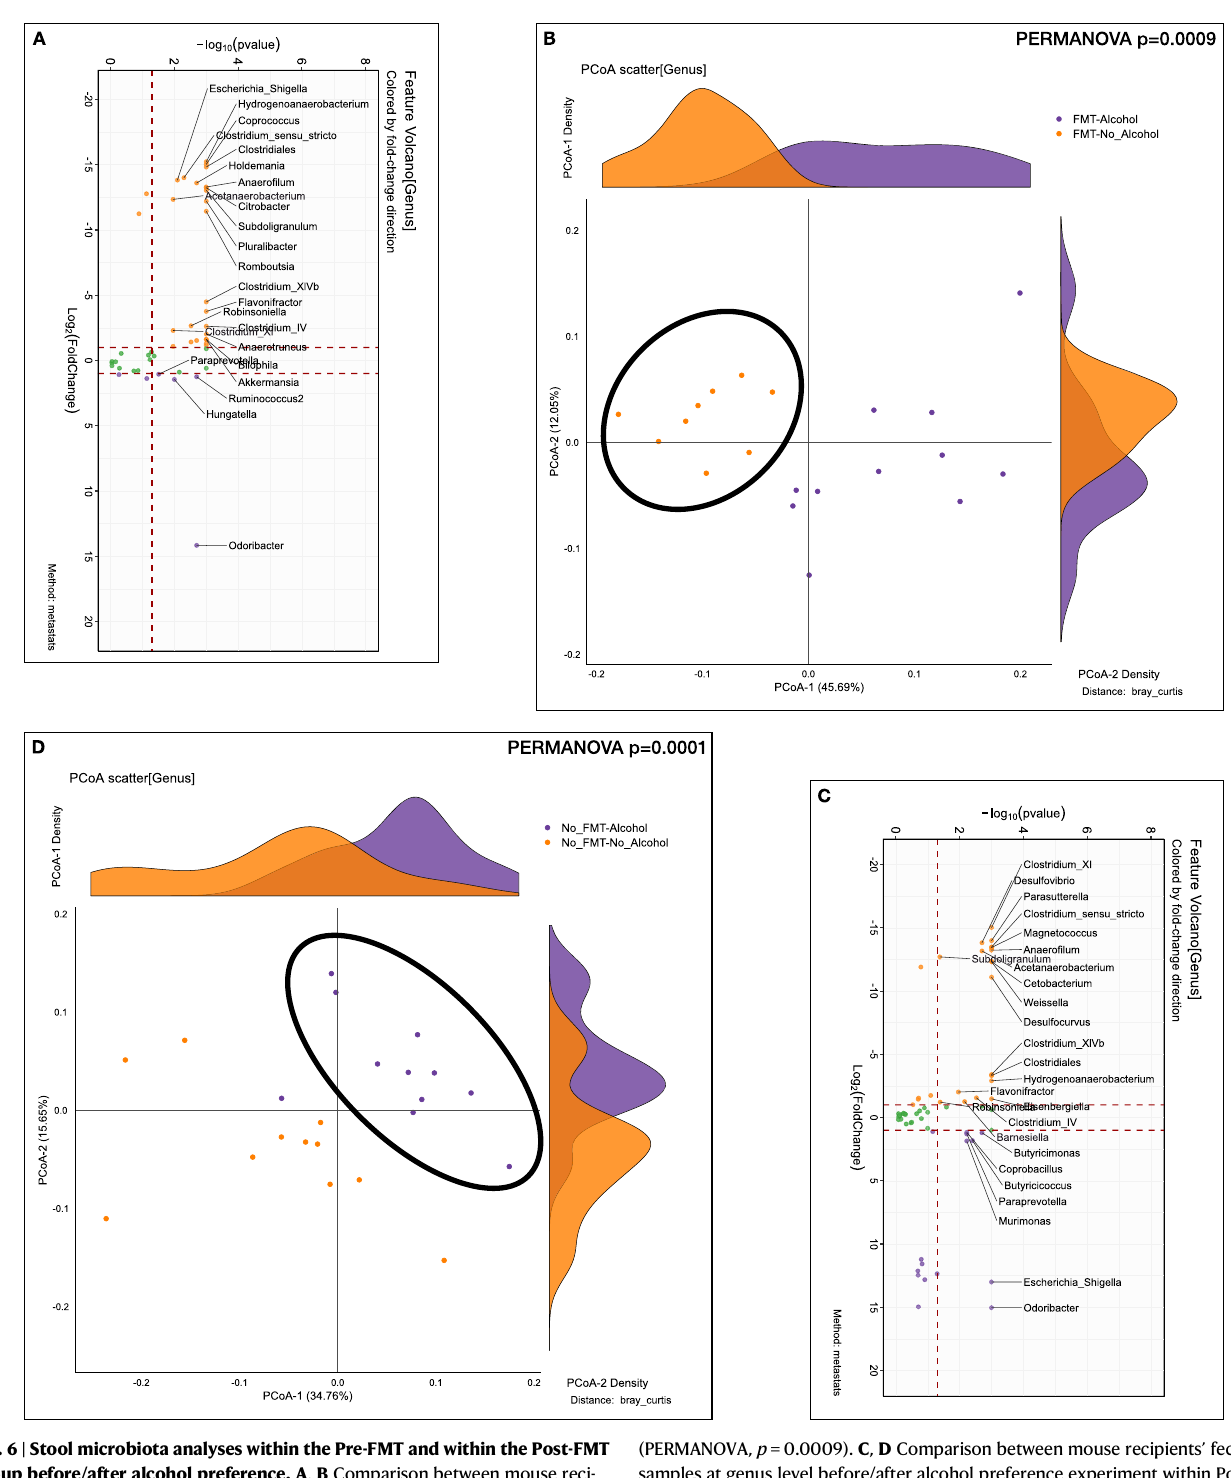
(PERMANOVA, p =0.0009). C , D Comparison between mouse recipients ’ fecal samples at genus level before/after alcohol preference experiment within Post- FMT. Purple: After alcohol, Orange: Before alcohol. C log2fold changes Volcano plotted against the log10 p value differences between the before alcohol (orange) andafteralcohol(purple). D β -diversityanalysisusingBray-CurtisdistanceonPCoA showing signi fi cant separation before/after alcohol preference